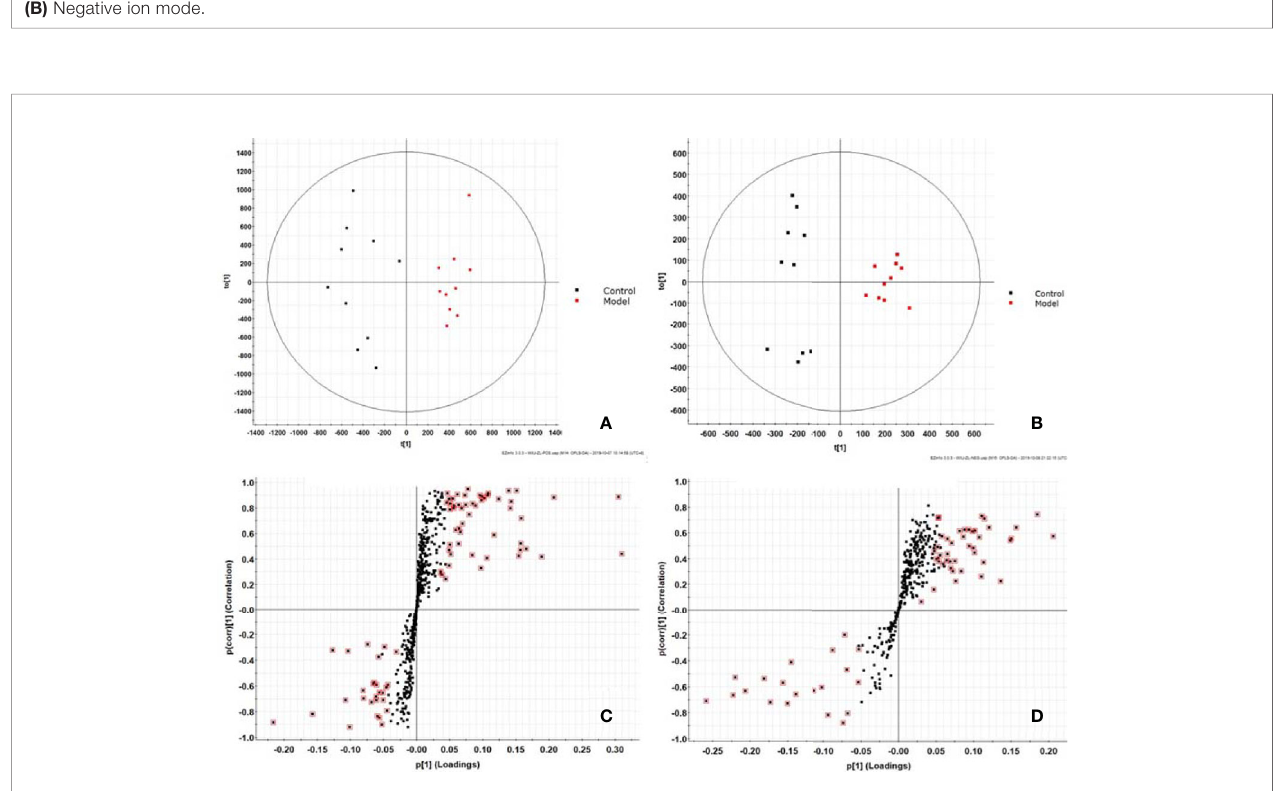
FIGURE 2 | Orthogonal partial least square discriminant analysis (OPLS-DA) metabolic pro fi ling of osteoporosis (OP) model: (A) score plot of serum pro fi le of control group and model group scanned by OPLS-DA analysis in positive mode. (B) Score plot of serum pro fi le of control group and model group scanned by OPLS-DA analysis in negative mode. (C) S-plot of serum pro fi le of control group and model group scanned by OPLS-DA analysis in positive mode. (D) S-plot of serum pro fi le of control group and model group scanned by OPLS-DA analysis in negative